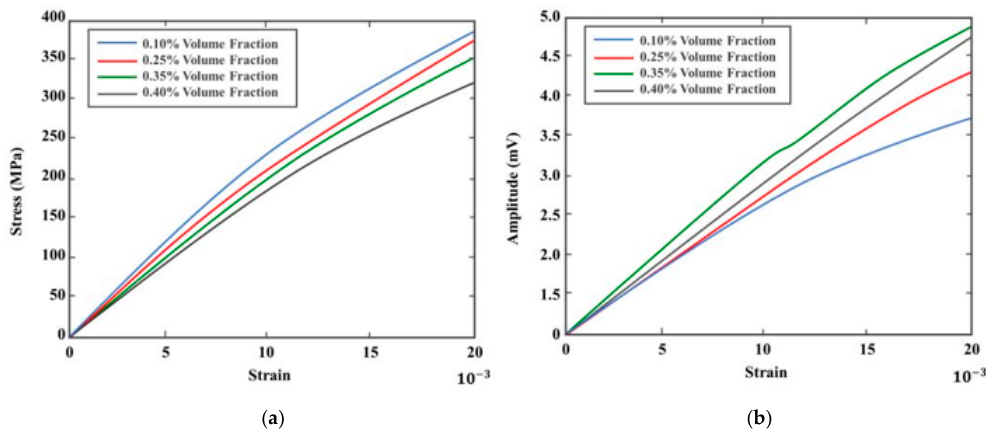
Figure 14. Composite with various volume fractions of SWCNTs: ( a ) stress–strain plot and ( b ) strain versus amplitude plot.